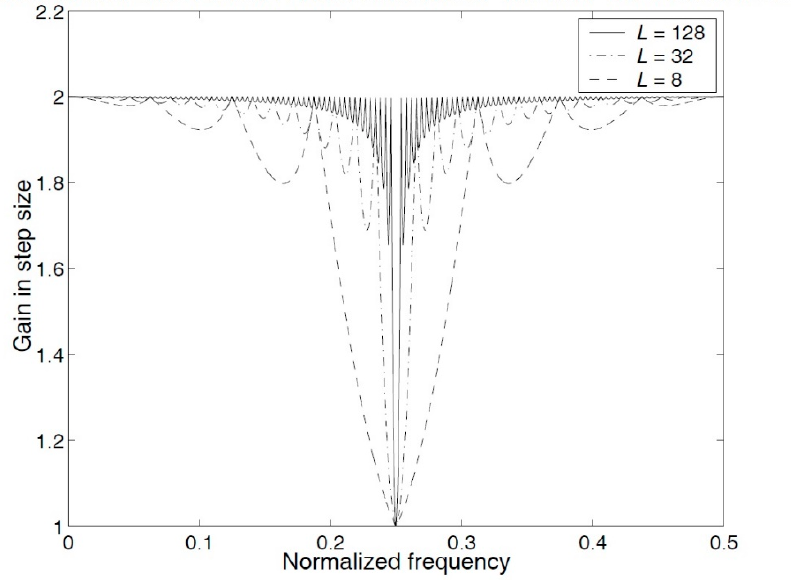
Figure A5. Gain in step-size for a single tone and different filter lengths, L = 8, 32, and 128 with decimation factor N = 2.